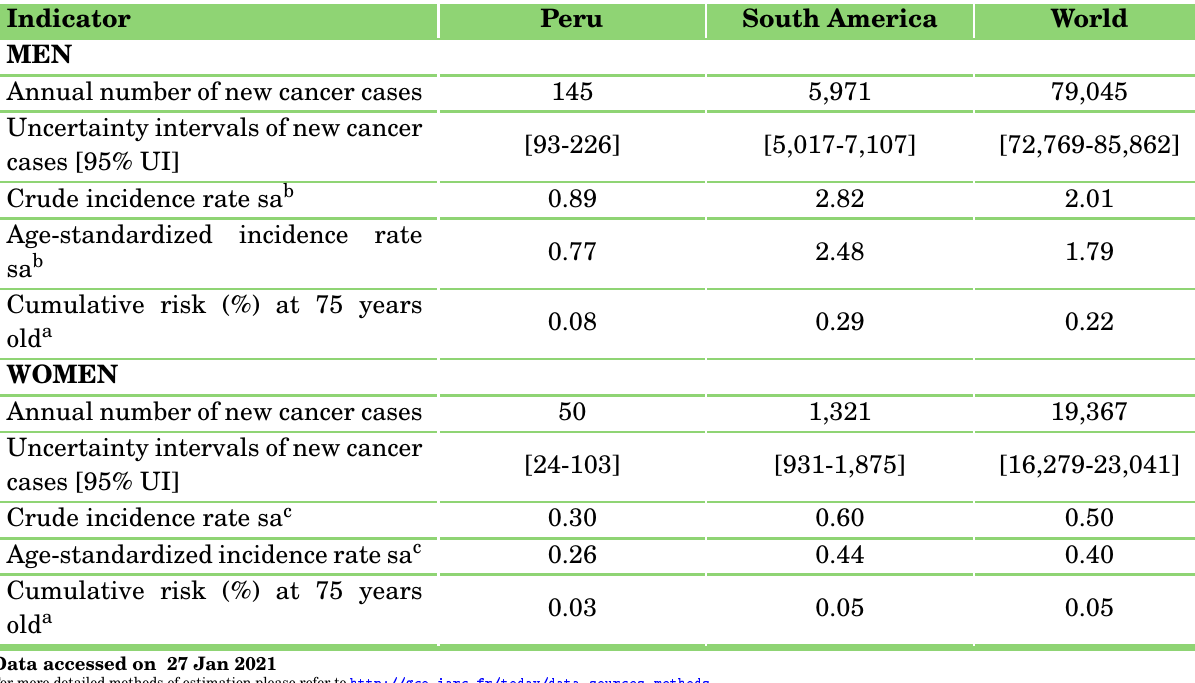
Table 15: Oropharyngeal cancer incidence in Peru (estimates for 2020) Indicator Peru South America